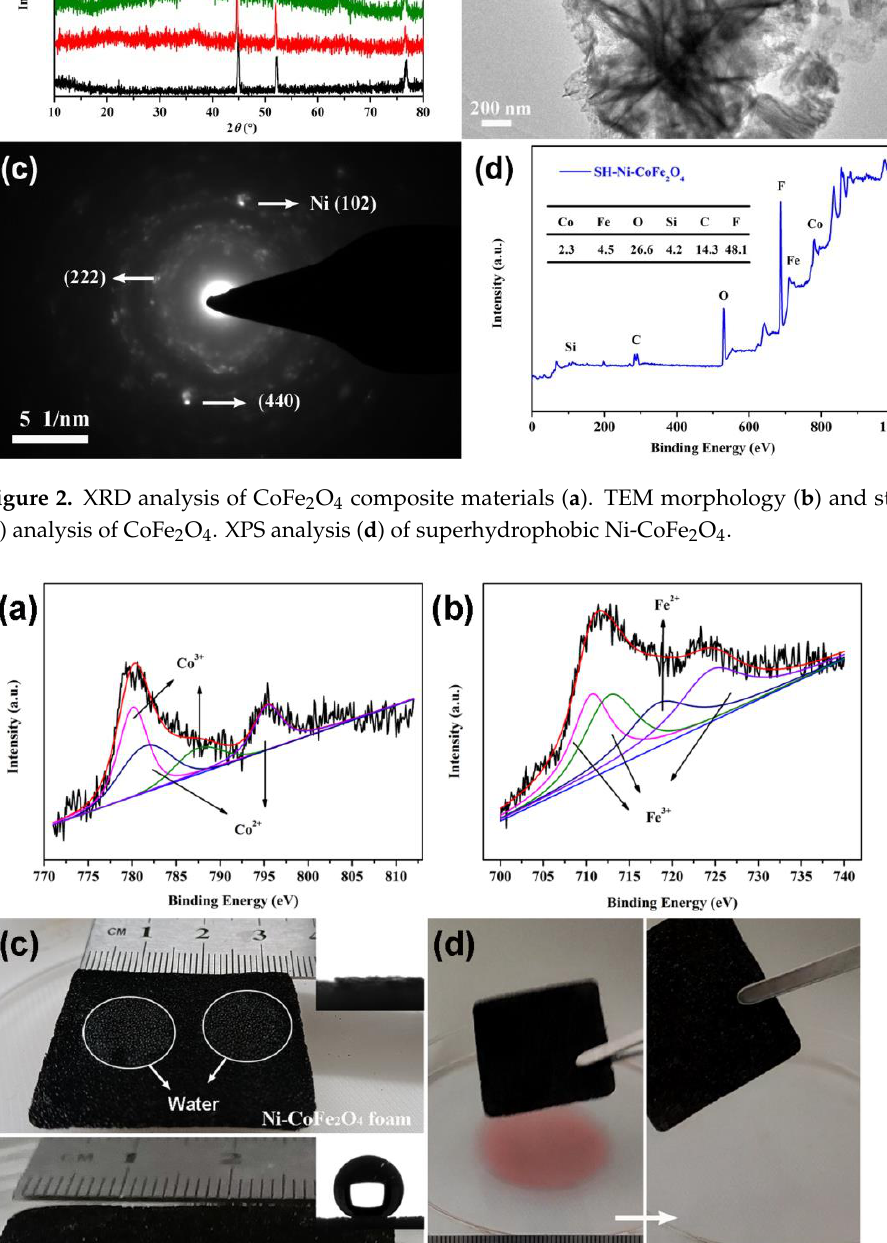
Figure 3. Fine spectrum of superhydrophobic Ni-CoFe 2 O 4 ( a , b ). Image of the Ni-CoFe 2 O 4 foam before and after silane modification ( c ). Selective organic solvent removal test for the Ni-CoFe 2 O 4 foam ( d ).